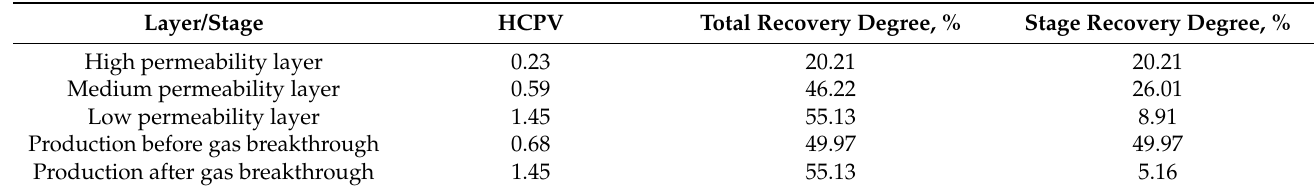
Figure 7. Relation between the recovery percent, gas–oil ratio and injection volume in the CO 2 injection process. Table 3. Recovery percent of each rhythm